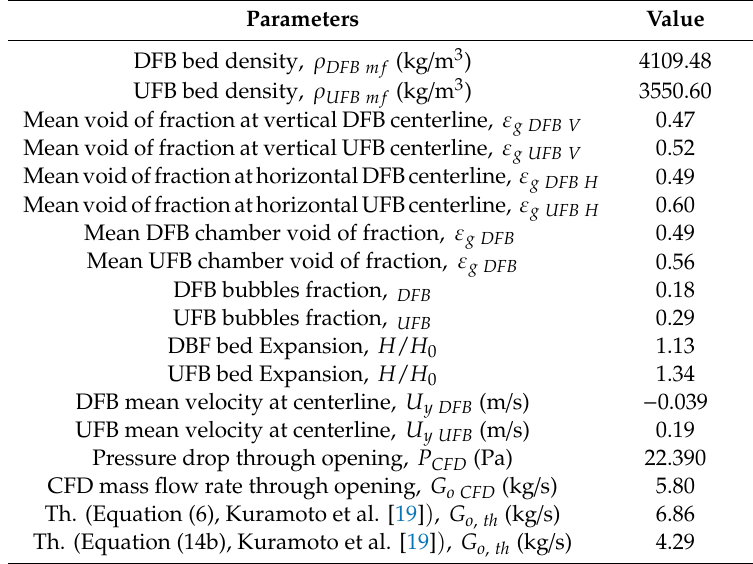
Table 2. Main numerical results related to CFD analysis of the ENEA’s cold model